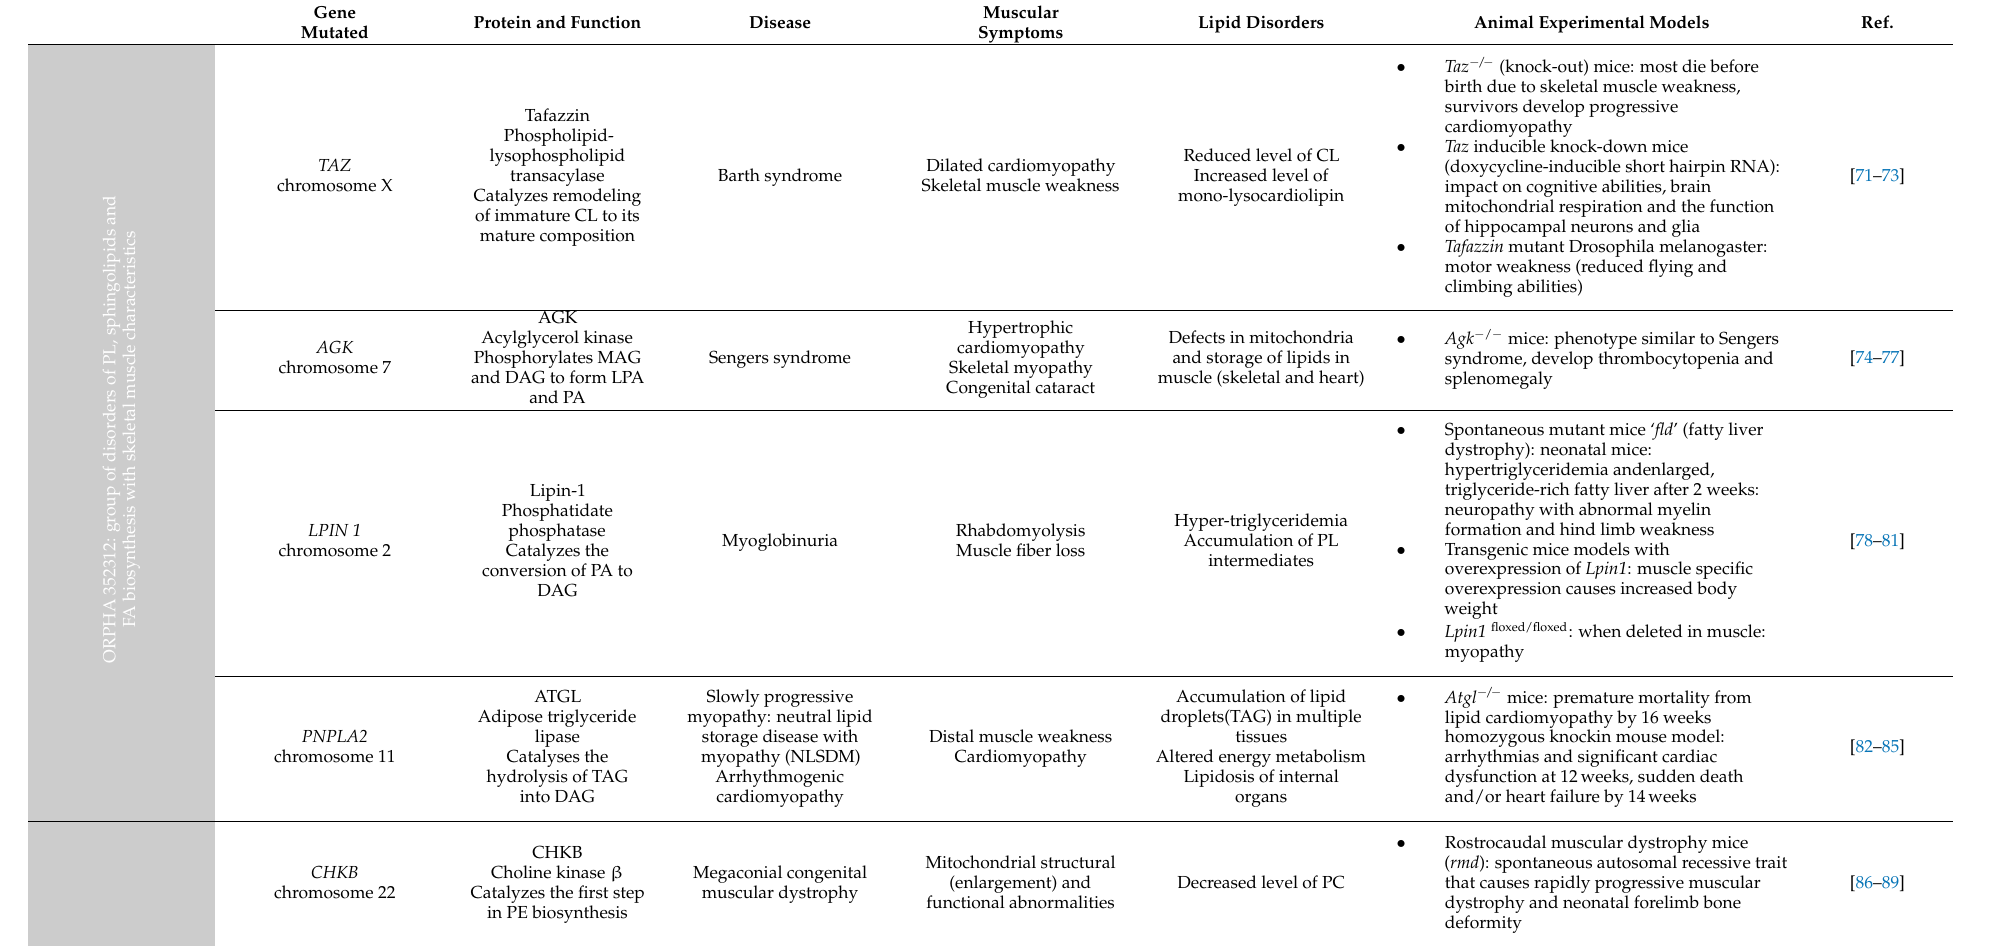
Table 3. PL alterations involved in muscular